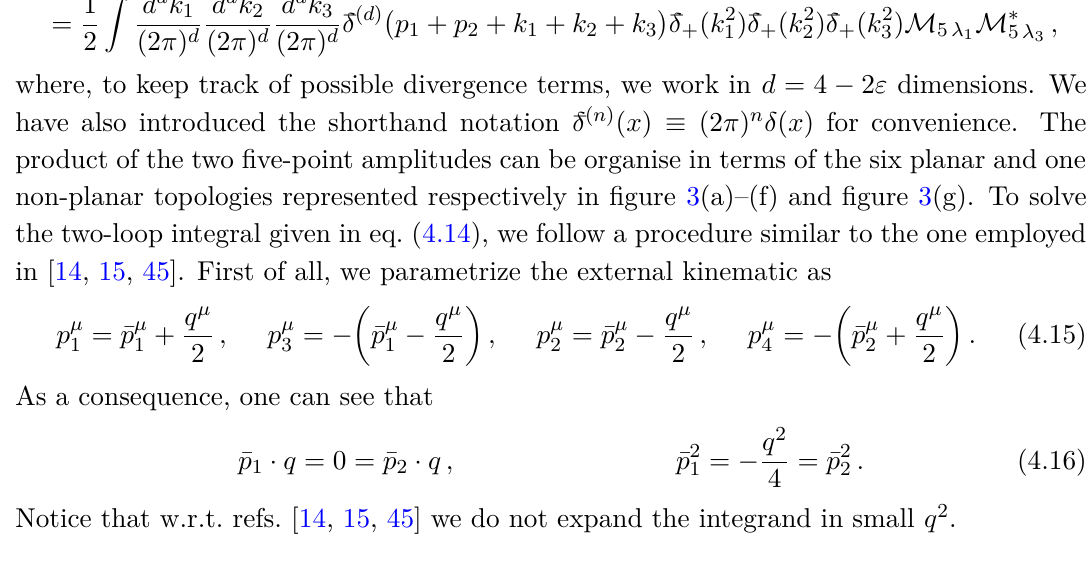
Figure 3 . Topologies arising from the contraction M 5 λ contributions w.r.t. the cut for (d), (e) and